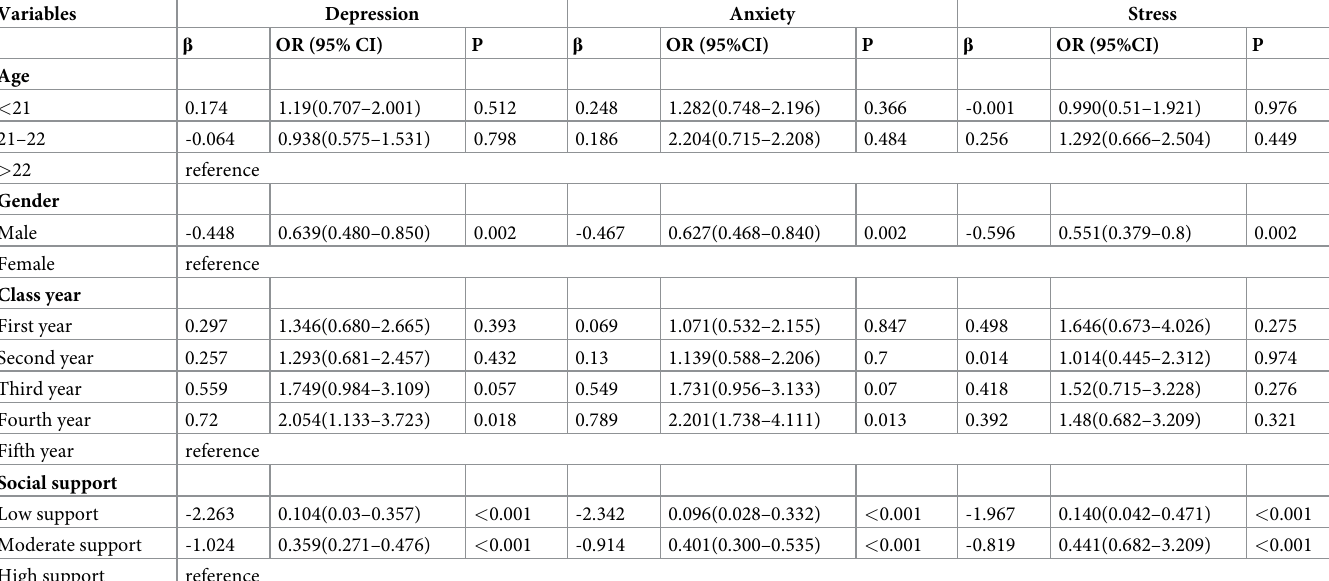
Table 4. Multiple logistic regressions with factors and social support predicting mental health symptoms. DOI: